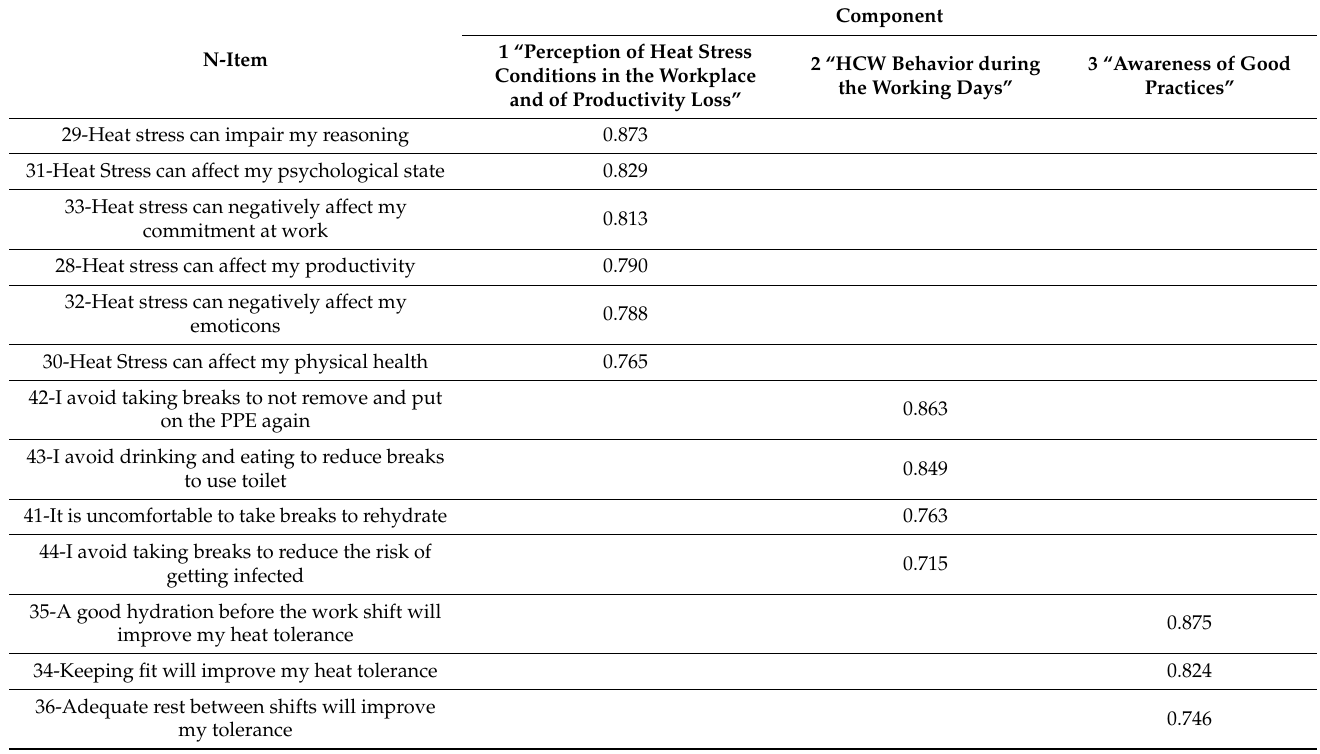
Table 2. Principal Component Analysis of section “Worker’s knowledge about thermal stress and attitudes towards PPE use”. Extraction method: Principal component analysis. Rotation method: Varimax with Kaiser